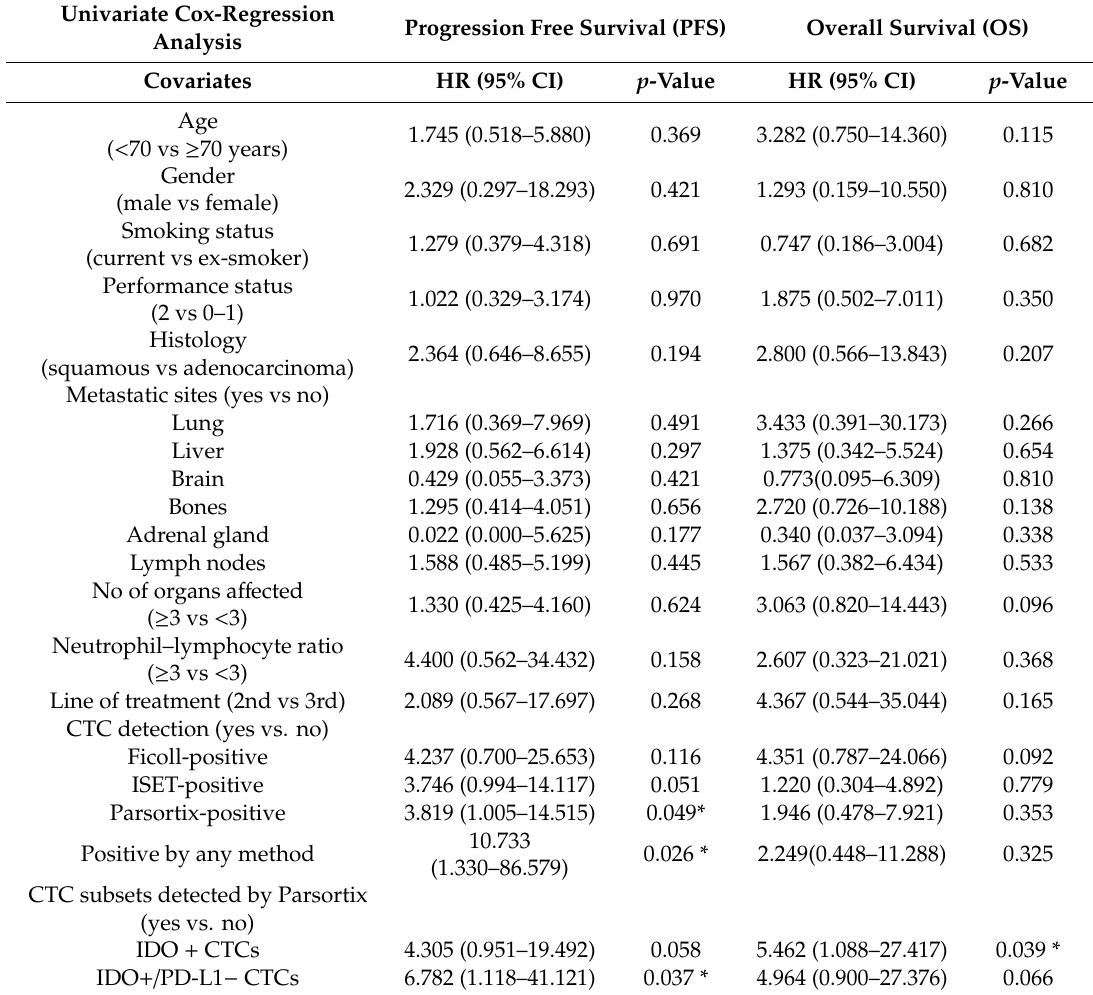
Table 4. Univariate Cox-regression analysis for PFS and OS among patients with NSCLC. Univariate